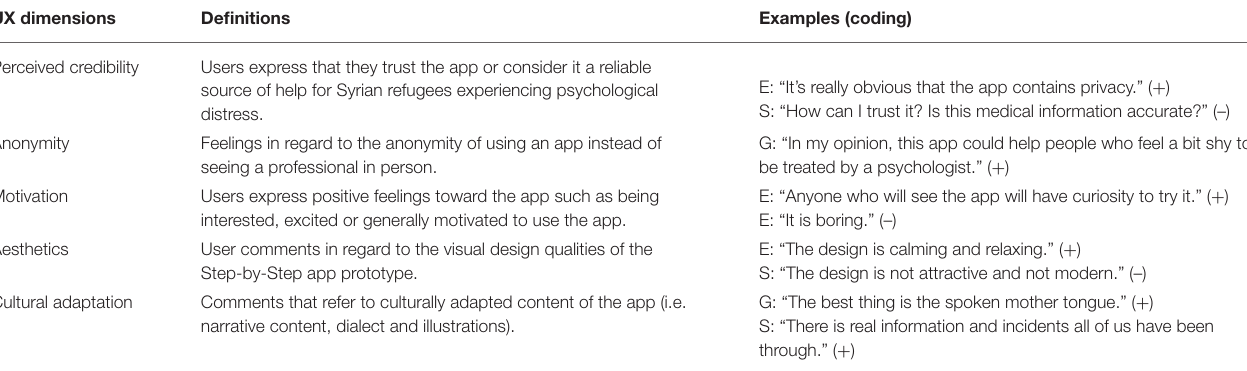
TABLE 4 | Definitions of user experience themes identified in the data through inductive analysis.